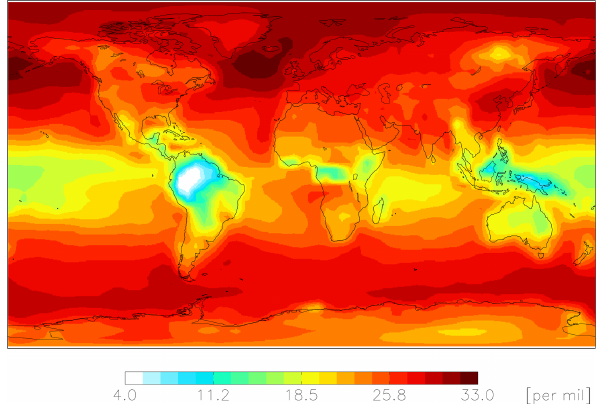
Figure 4. Modeled annual-mean (cid:49) 17 O(nitrate) below 1km altitude for the cloud chemistry